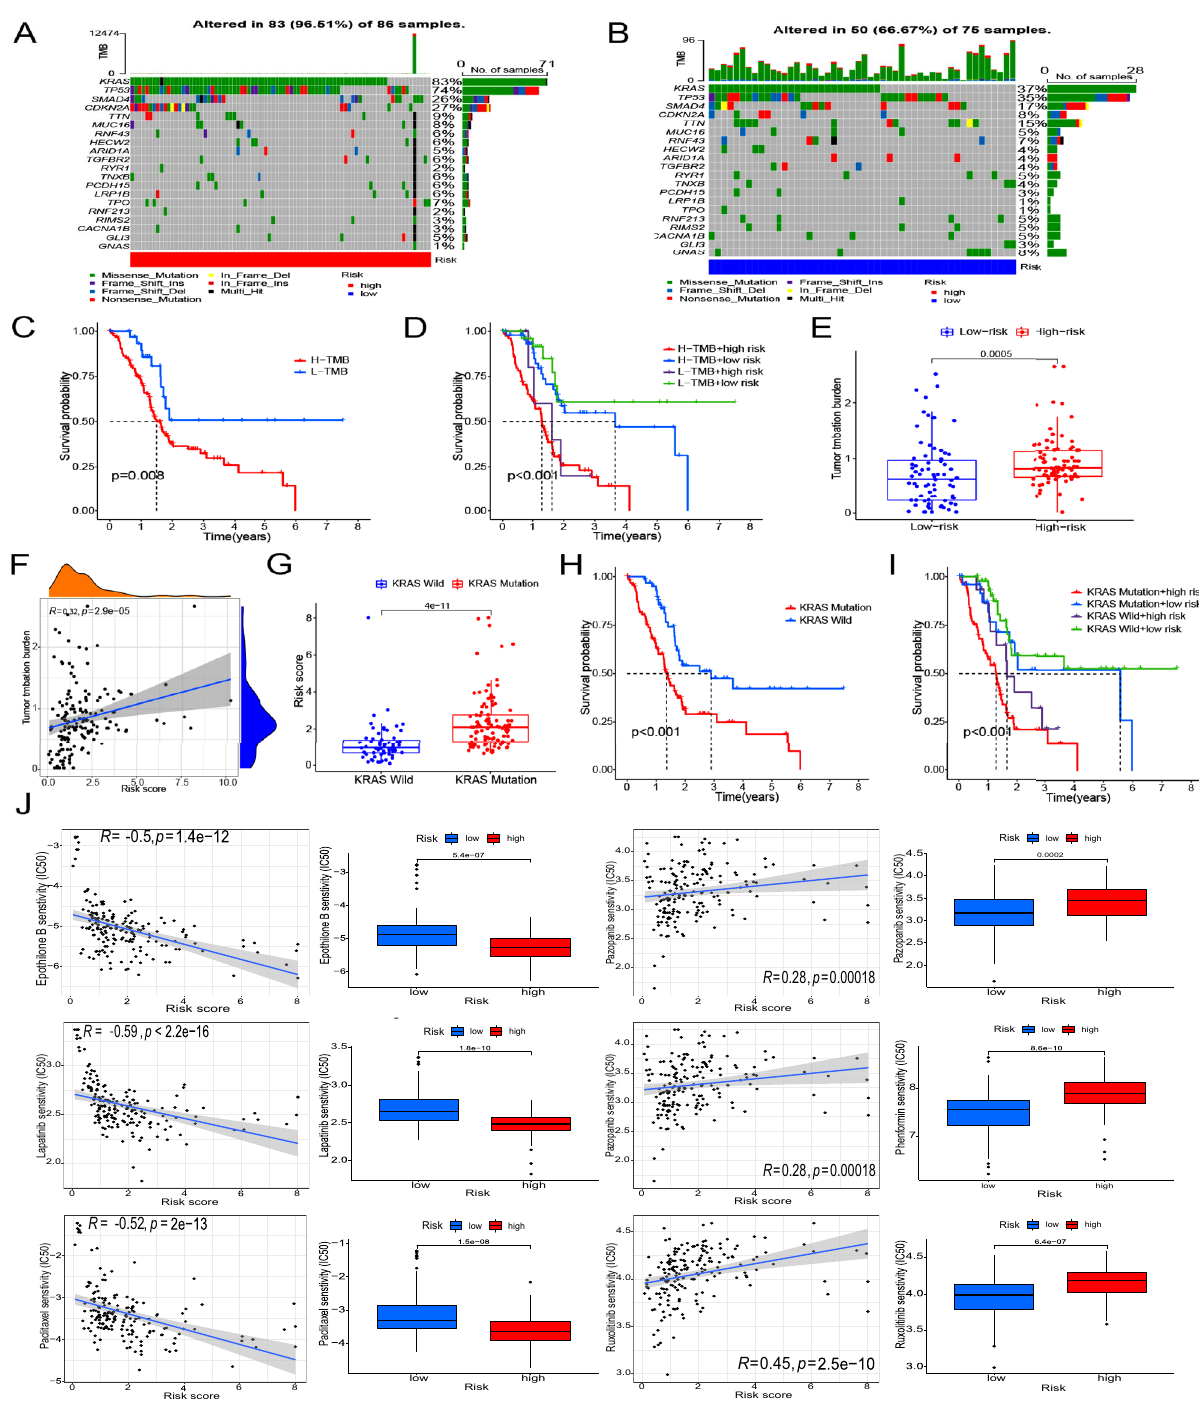
Figure 9. Tumor mutation burden (TMB), KRAS gene mutation, and drug sensitivity analysis. ( A , B ) Mutation waterfall plots for high- and low-risk groups. ( C ) Kaplan–Meier survival analysis between high and low TMB. ( D ) Kaplan–Meier survival analysis of different TMB levels combined with the risk score. ( E ) Analysis of TMB differences between high- and low-risk groups. ( F ) Correlation between risk score and TMB. ( G ) Boxplot showing differences in risk score between wild-type and mutant KRAS. ( H ) Kaplan–Meier survival analysis of wild-type and mutant KRAS . ( I ) Kaplan–Meier survival analysis of KRAS mutations combined with risk score. ( J ) Correlations between risk score and sensitivity to six drugs (pazopanib, phenformin, ruxolitinib, lapatinib, epothilone, and paclitaxel). Differences in drug sensitivity between the high- and low-risk groups were also